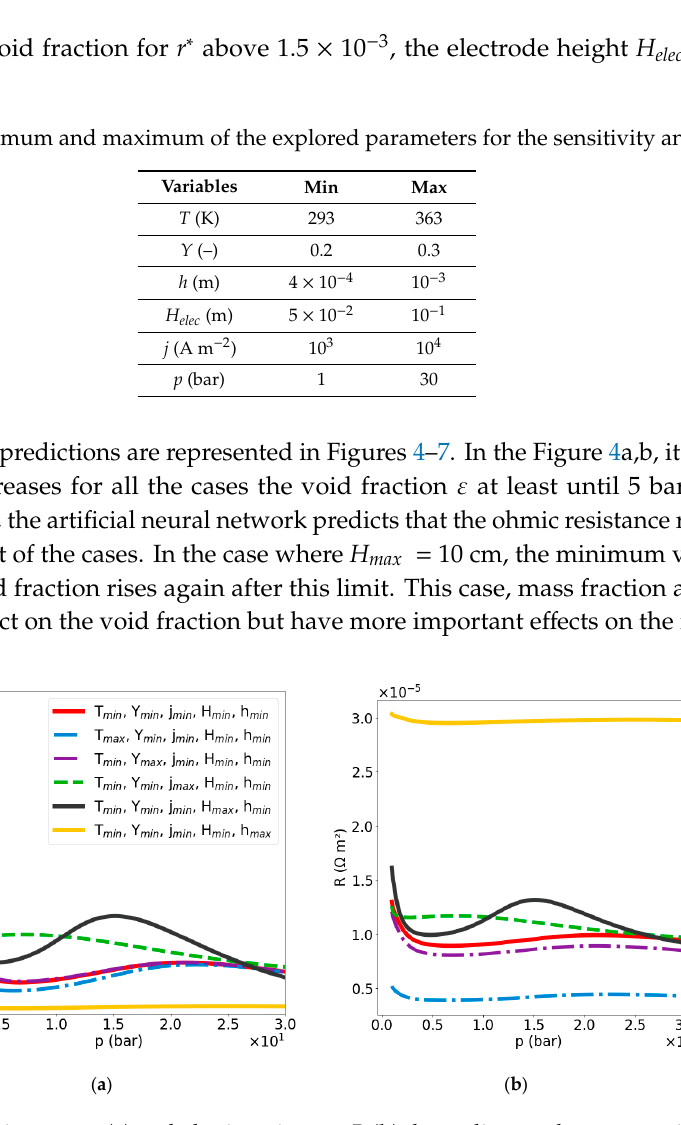
ANN ( a ) and ohmic resistance R ( b ) depending on the pressure in [1–30] bar. Appl. Sci. 2020 , 10 , x FOR PEER REVIEW